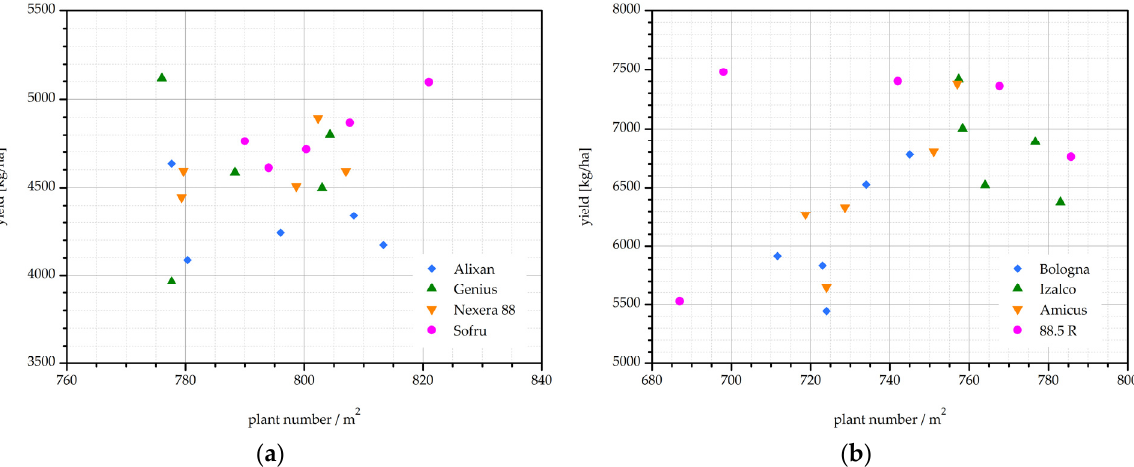
Figure 6. Correlation between plant emergence / m 2 and yield (kg/ha) of the field experiments in the years ( a ) 2019/20 and ( b ) 2020/21.